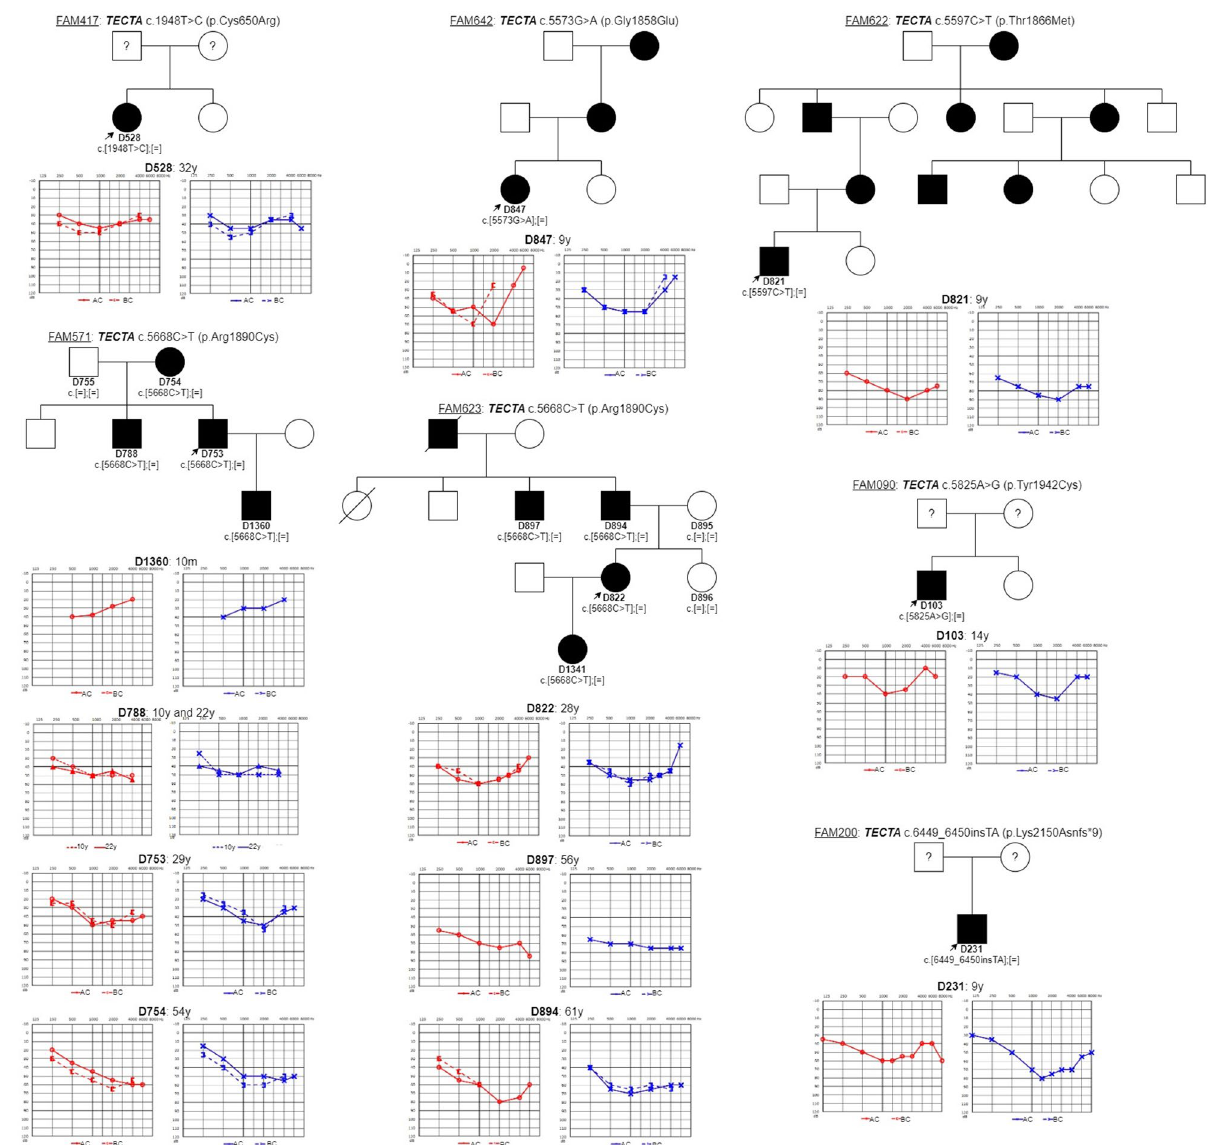
Figure 1. Pedigrees and audiograms of the patients with pathogenic and VUS variants in TECTA gene. The age at examination by pure tone audiometry is indicated. The youngest subject D1360 (born in 2018) from family FAM571 was only investigated by Auditory Steady-State